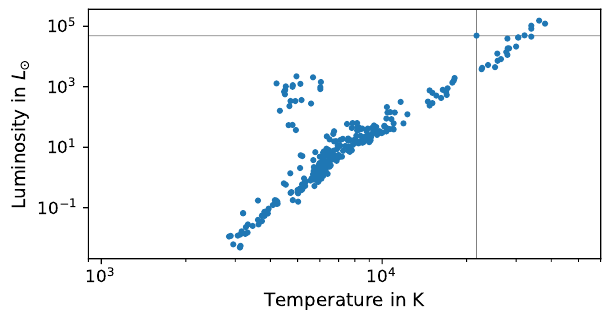
Fig. 26.— Hertzsprung-Russell diagram using physical quanti- ties (temperature and luminosity) instead of spectral classes and luminosity classes. Data from DEBCat